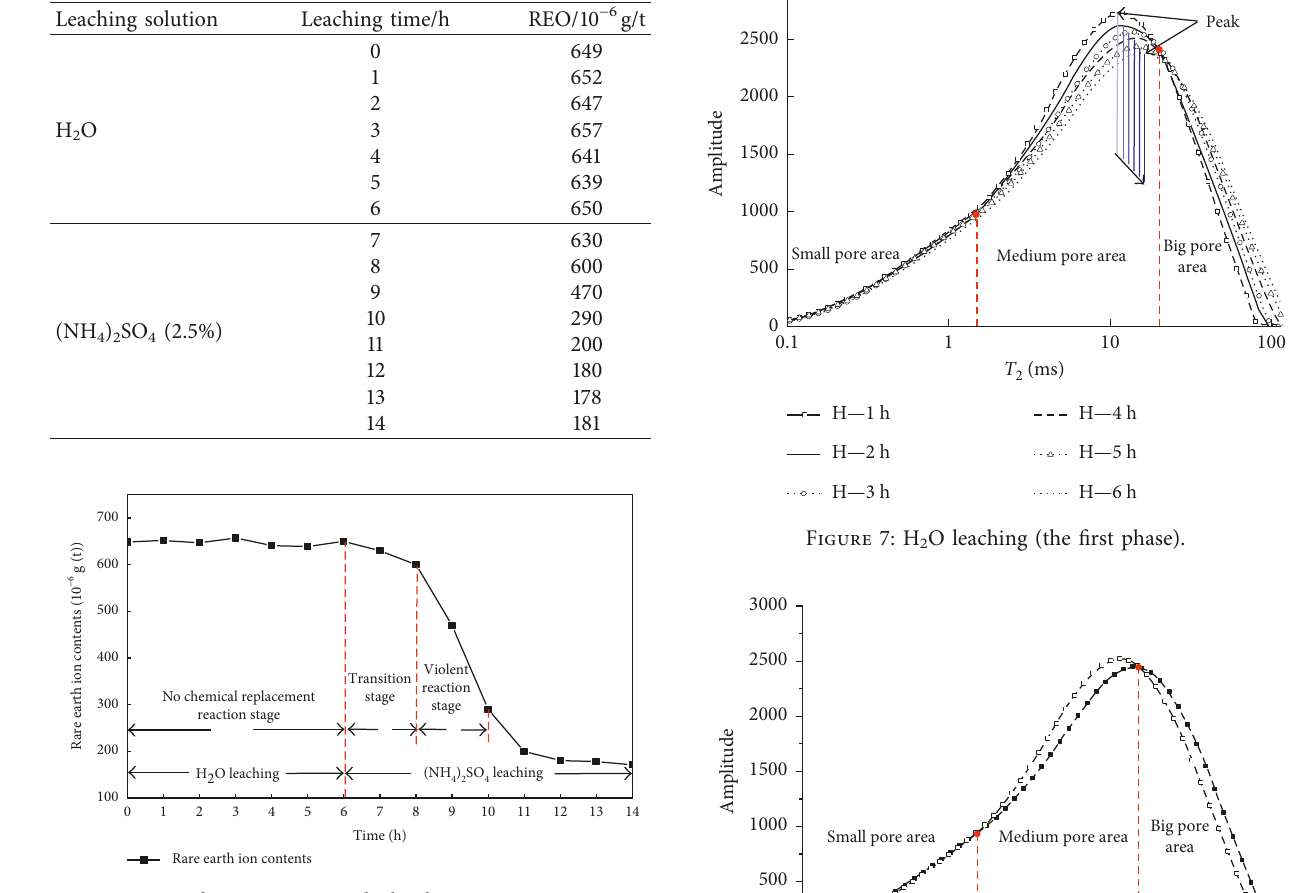
Table 2: REO in the leaching